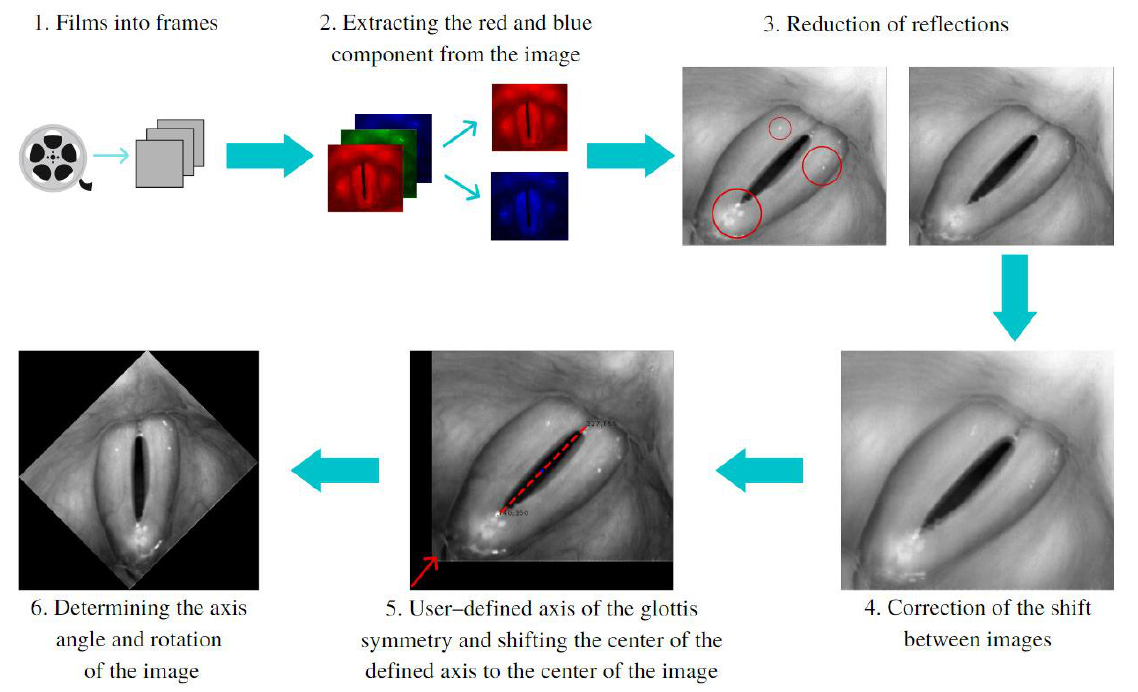
Figure 1. The multistep pre-processing of the LHSV images. Red circles (in step 3) indicate areas of the image reflections and the dashed line (in step 5) marks axis of the glottis.